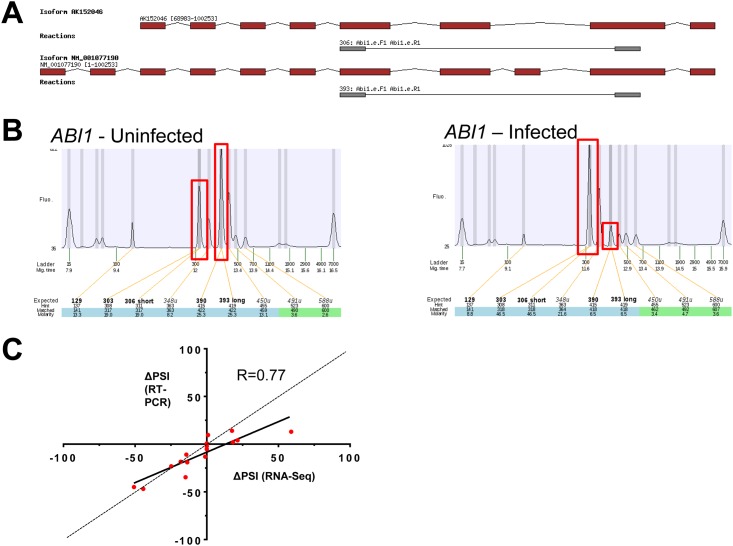
Validation of ASEs dysregulated in infected cells.(A) Overview of two isoforms encoded by the ABI1 gene. Exons are depicted in red and the intervening introns are shown as thin black lines (not to scale). The primers used to detect the ASE by RT-PCR assays are shown in gray and the sizes of the expected amplicons (306 nt and 393 nt) are also indicated. The genomic coordinates of these two representative isoforms are also indicated. (B) Cellular mRNAs isolated from both uninfected and infected cells were analyzed by RT-PCR using specific primers to detect both forms of the modified ASE encoded by the ABI1 gene. The amplified products were analyzed by automated chip-based microcapillary electrophoresis. Capillary electropherograms of the PCR reactions are shown. The positions and the amplitude of the detected amplicons are highlighted by red boxes. The positions of the internal markers are also indicated. The data shows the increase in the relative abundance of the short form (306 nt) and a decrease in the abundance of the long form (393 nt) upon viral infection. (C) Correlation between PSI values obtained from RNA-Seq and RT-PCR data. The analysis was performed on 16 selected ASEs (Abi1, Cwc22, Eif4a2, Hnrnpa2b1, Il34, Srsf3, Srsf5, Alkbh1, Cdkn2aip, Cflar, Hif1a, Mdm2, Serbp1, Sfswap, Smc2, Tbp). In all cases, the changes in AS levels detected by RT-PCR and the ones revealed through transcriptome sequencing displayed high levels of correlation (r >0.77). Sanger sequencing was also realized on several ASEs to confirm that RT-PCR reaction is specific and amplifies predicted ASE.